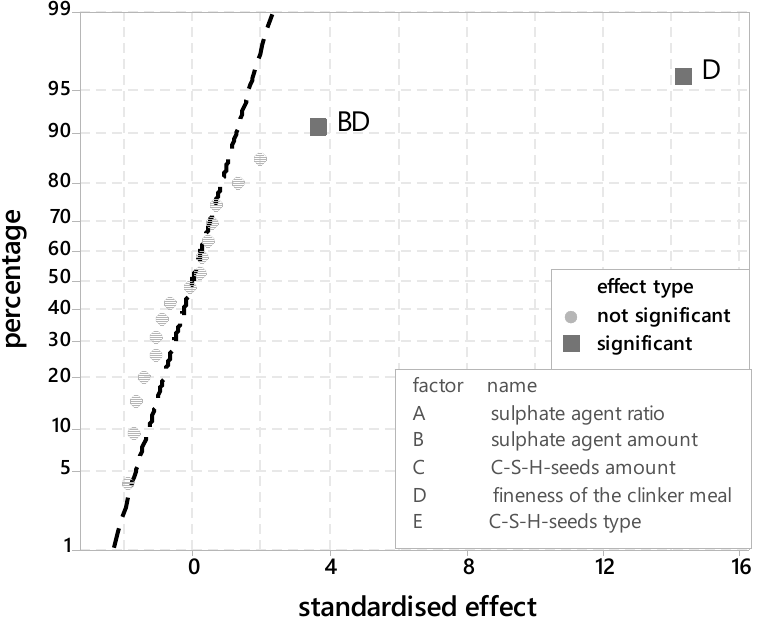
Figure 3. Probability plot for standardised effects for the silicate phase (XRD-peak 32-32.5 ◦ 2 ϑ ).